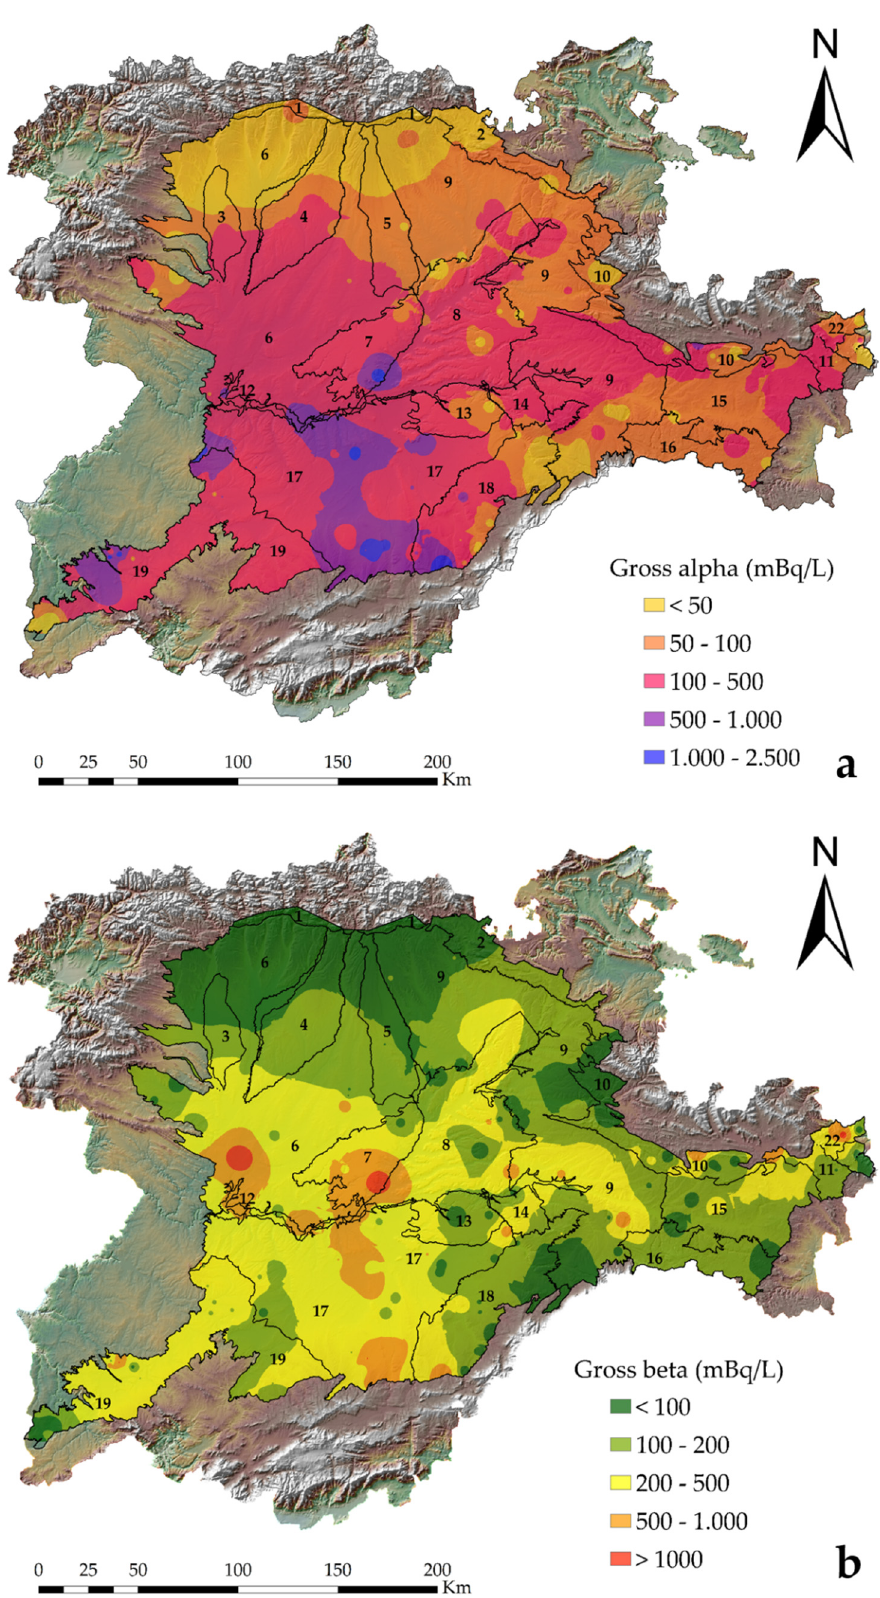
Figure 5. Spatial distribution of the gross alpha activity ( a ) and gross beta activity ( b ) screening levels for the hydraulically unconfined aquifer system of the Duero Basin. The hydrogeological unit names corresponding to the numbers illustrated are referred to in Figure 2.